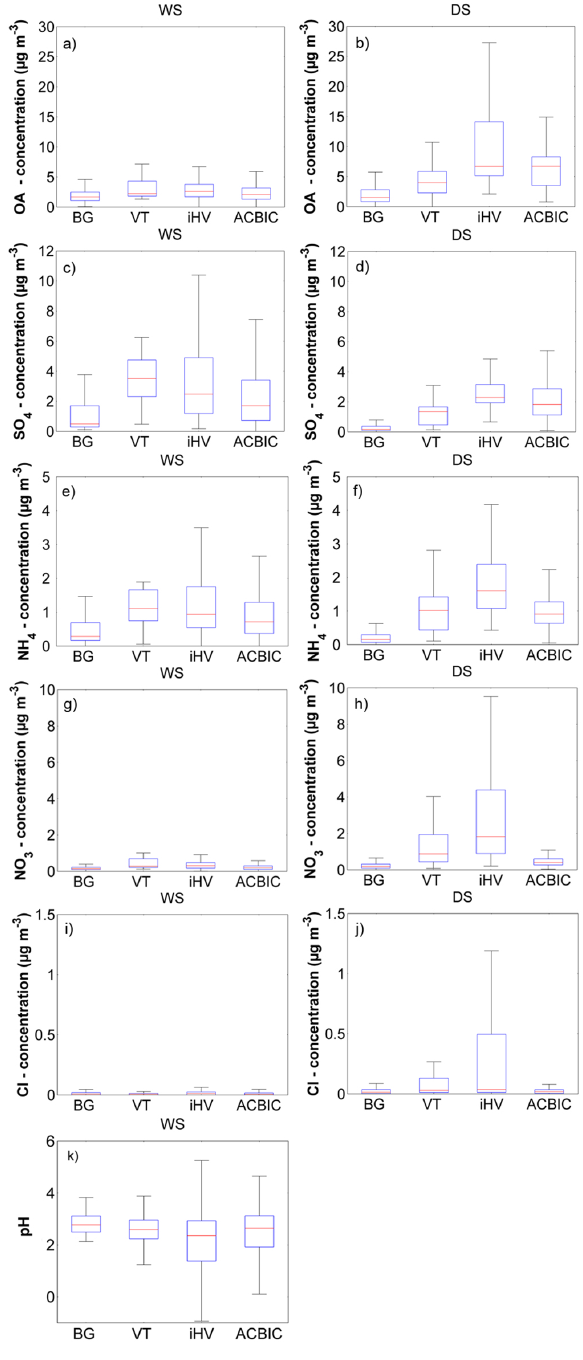
Fig. 6. NR-PM 1 composition as function of air masses classified as passing over the four regions, i.e., BG, VT, iHV and ACBIC, defined in Sect. 2.5 for the wet season (WS) and the dry season (DS) as well as pH for WS ( k ). The box plots indicate 25th and 75th percentiles and the line within the box the median. Whiskers present 5th and 95th